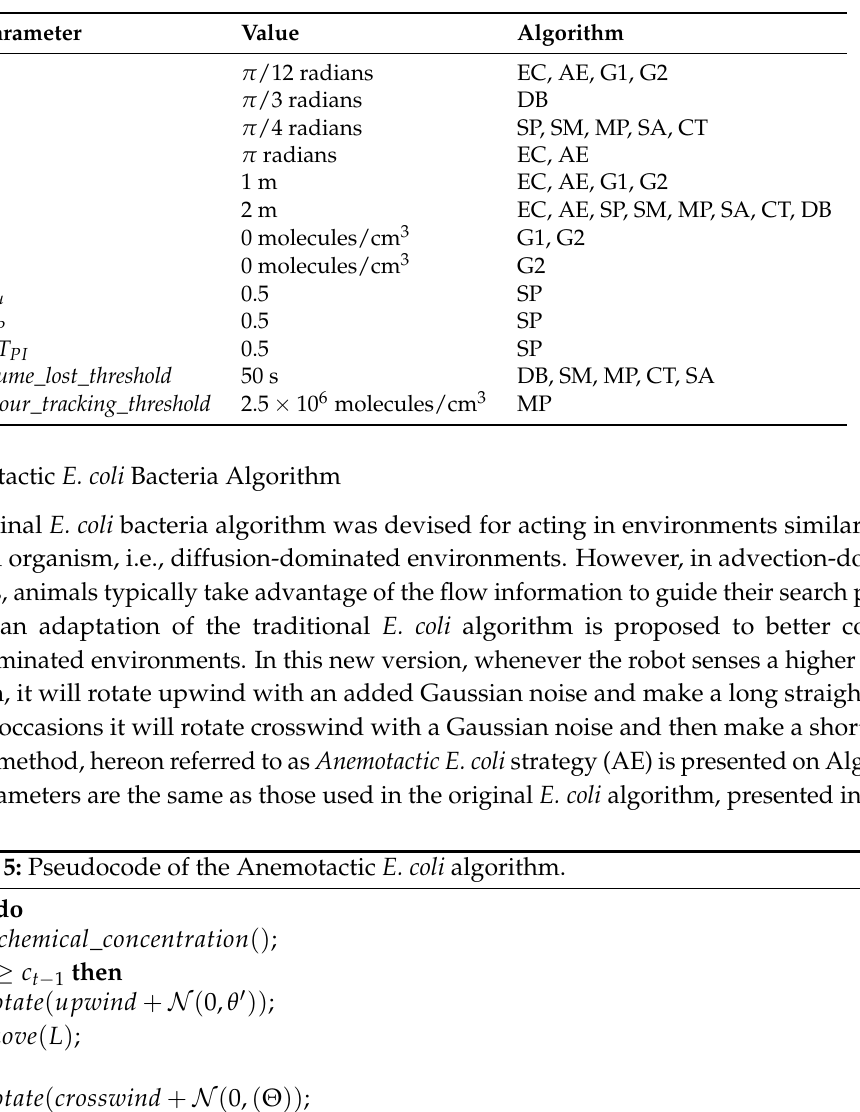
Table 4. Parameters used in the various strategies.